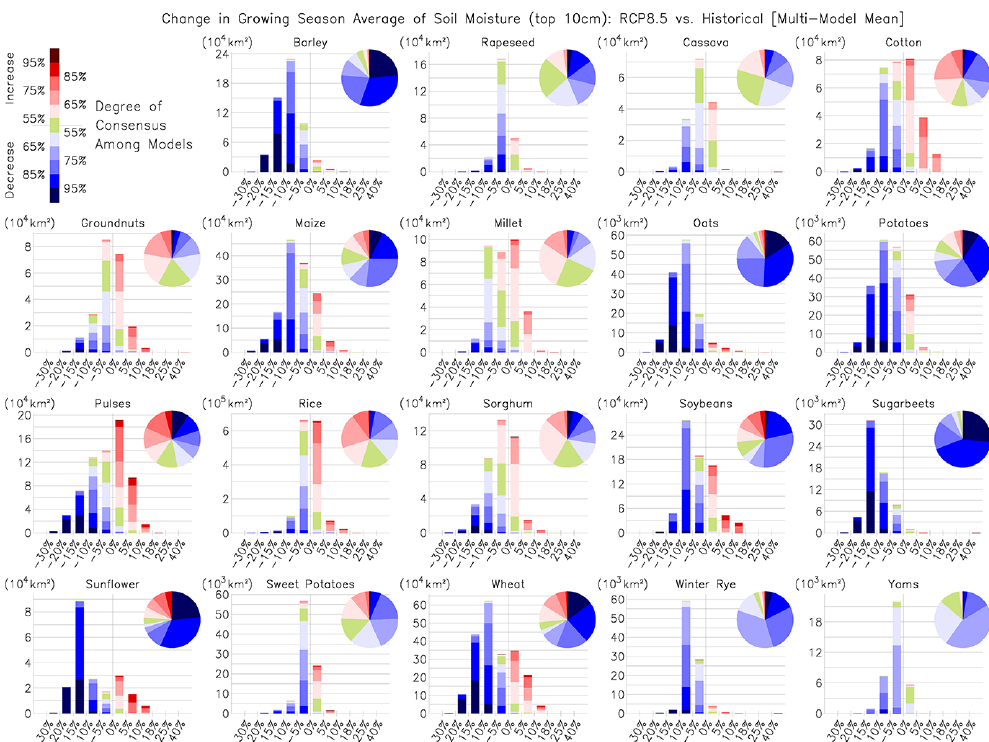
Figure 7. Probability distribution (total areas) of changes from the historical case to the RCP8.5 case in mean growing season top 10cm soil moisture for each crop, with the colored shading indicating the degree of consensus among models and the area of each color in the bars and pie charts proportional to the area covered by that level of